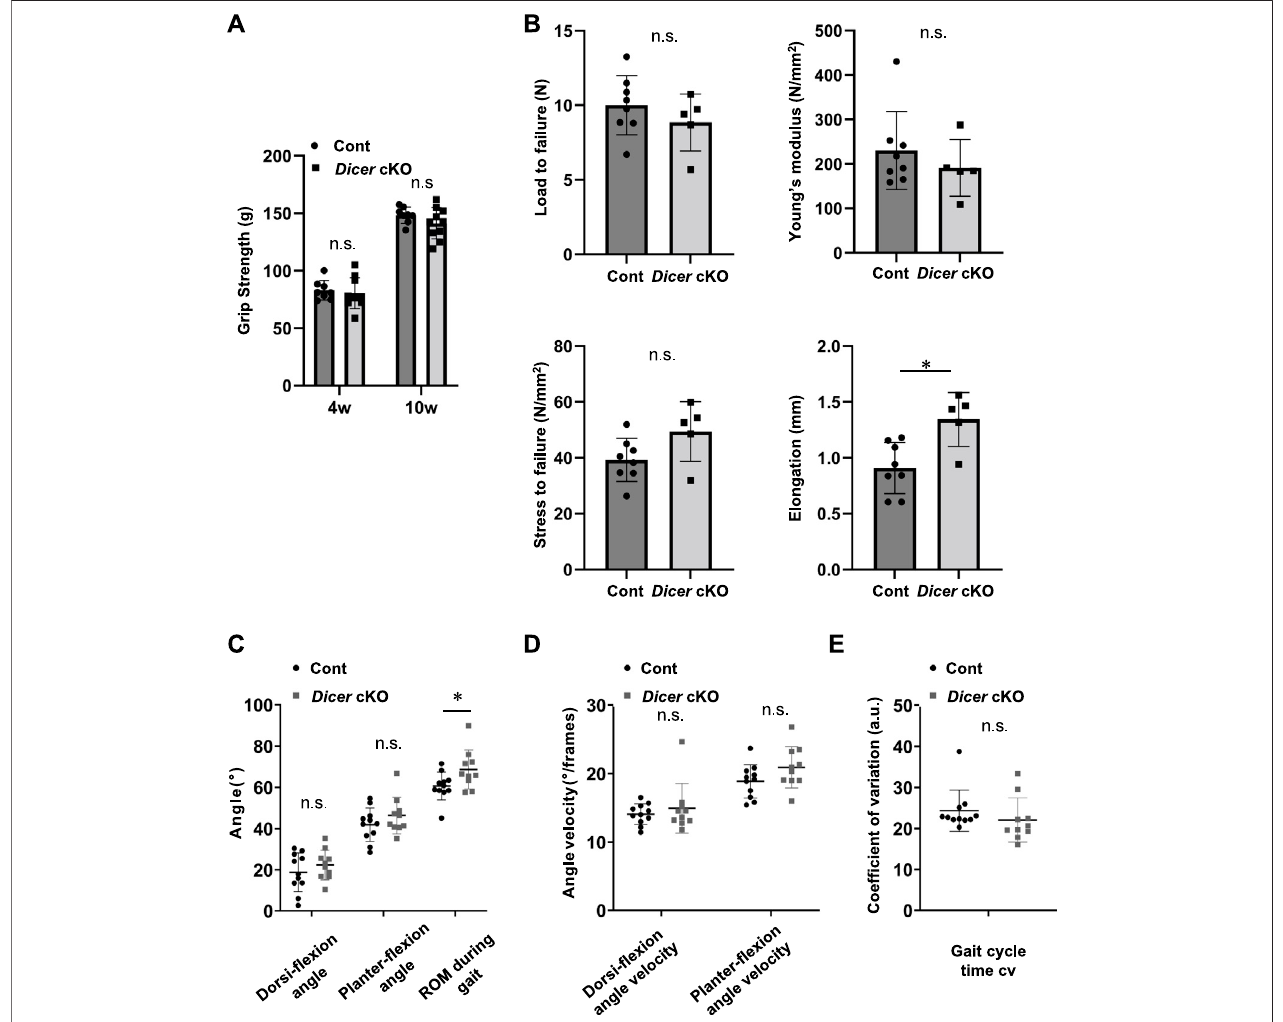
FIGURE3| Function oftendon in Dicer cKO mice. (A) Grip strength offorelimb inCont ( n =8) and Dicer cKO ( n =10) mice at 4and 10 weeks ofage. (B) Load and stress to failure in Achilles tendons of Cont ( n = 8) and Dicer cKO ( n = 5) mice at 10 weeks of age. (C) Gait analysis was performed using Cont ( n = 11) and Dicer cKO ( n = 10) mice at 10 weeks of age. Maximum dorsi- fl exion angle, plantar fl exion angle, ROM during gait (C) , dorsi- fl exion angular velocity, plantar fl exion angular velocity (D) , and gait cycle time CV (E) . Data are represented as mean ± S.D. Comparison of mean values was performed using (A) Welch ’ s t test with Holm-Sidak correction for multiple comparison, and (B – E) Welch ’ s t test; * p < 0.05 versus Cont. n.s.: no signi fi cant difference.